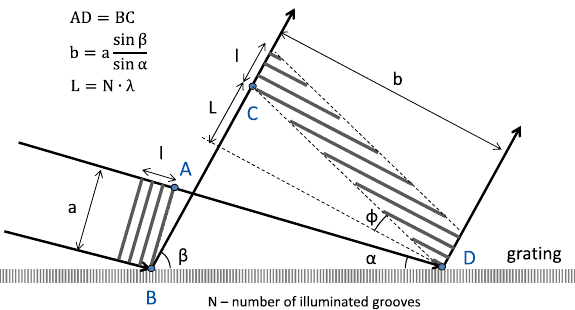
FIG. 18. Geometrical illustration of pulse front tilt created by an optical element with angular dispersion